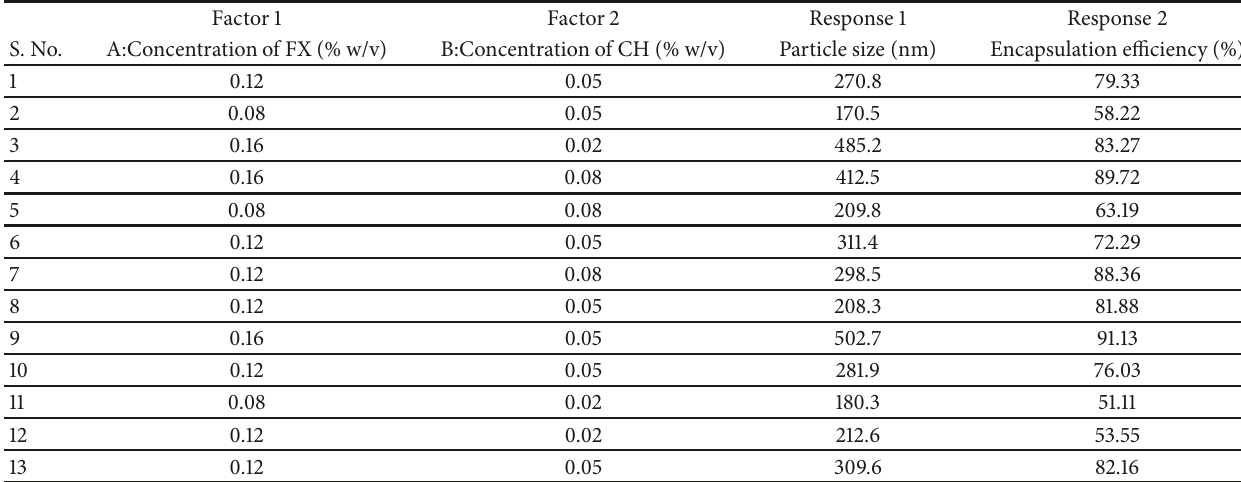
Table 1: Various batches of polyelectrolyte complex nanoparticles with particle size and encapsulation